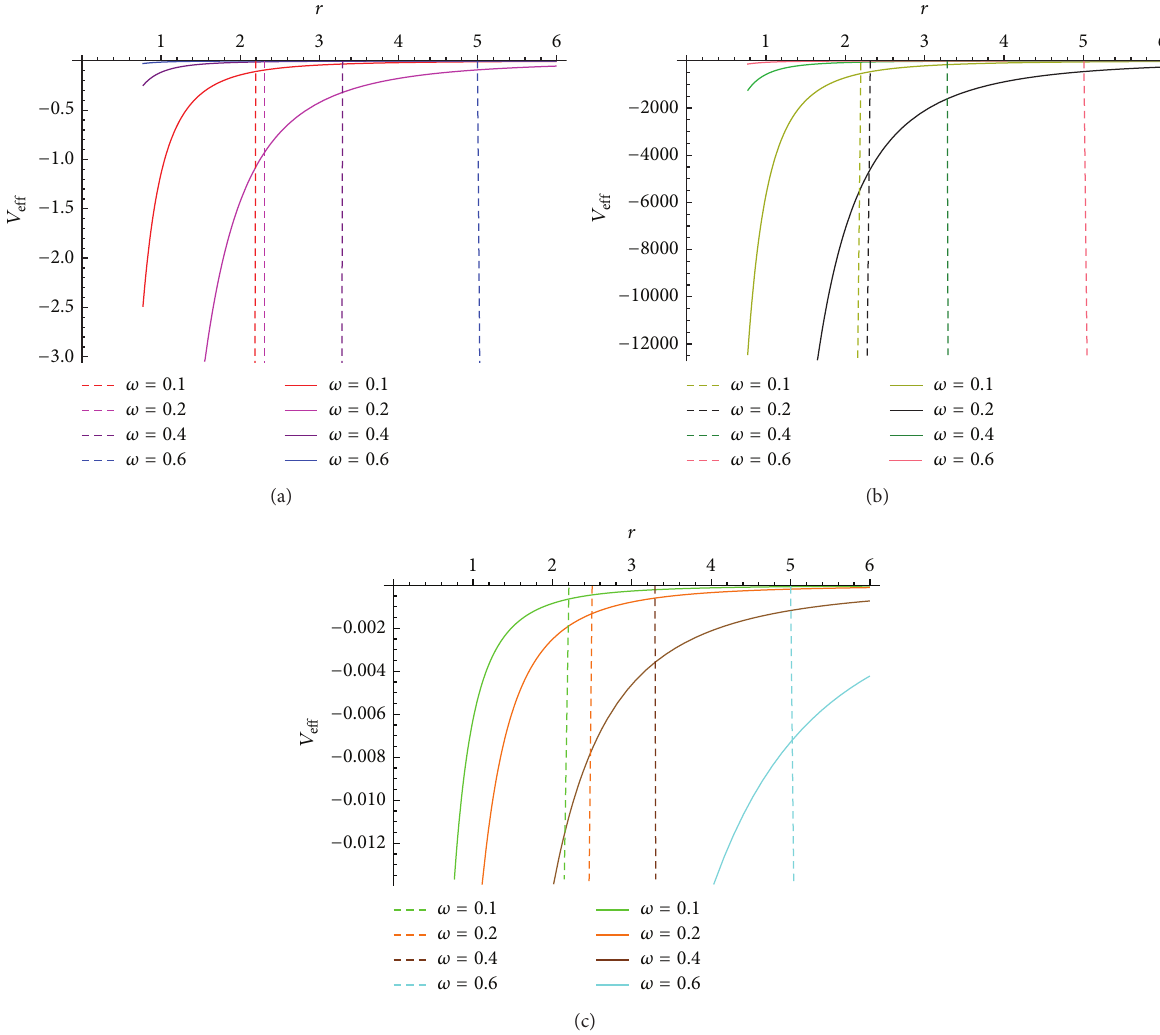
) versus 𝑟 corresponding to 𝐿 = 3.22 (a), 𝐿 = 1 (b), and 𝐿 = 5 (c) with 𝑀 = 1 . Here, solid eff and 𝑟 ℎ eff